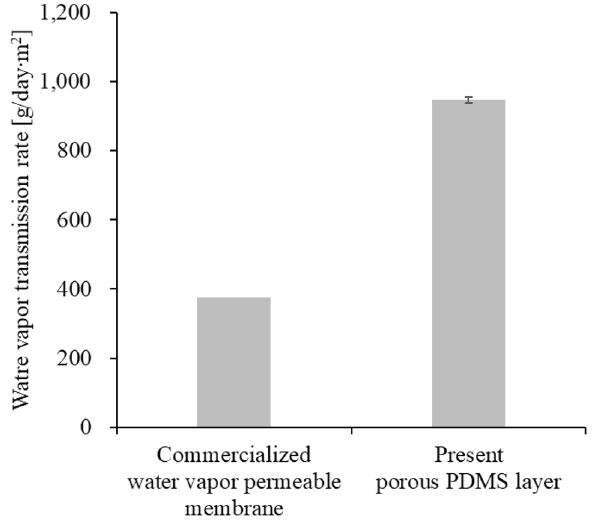
Figure 5. Water vapor transmission rate of the commercialized water vapor permeable membrane (Opsite flexfix, Smith & nephew) and the present porous PDMS layer, fabricated at t e = 150 °C and WMR = 0.5.